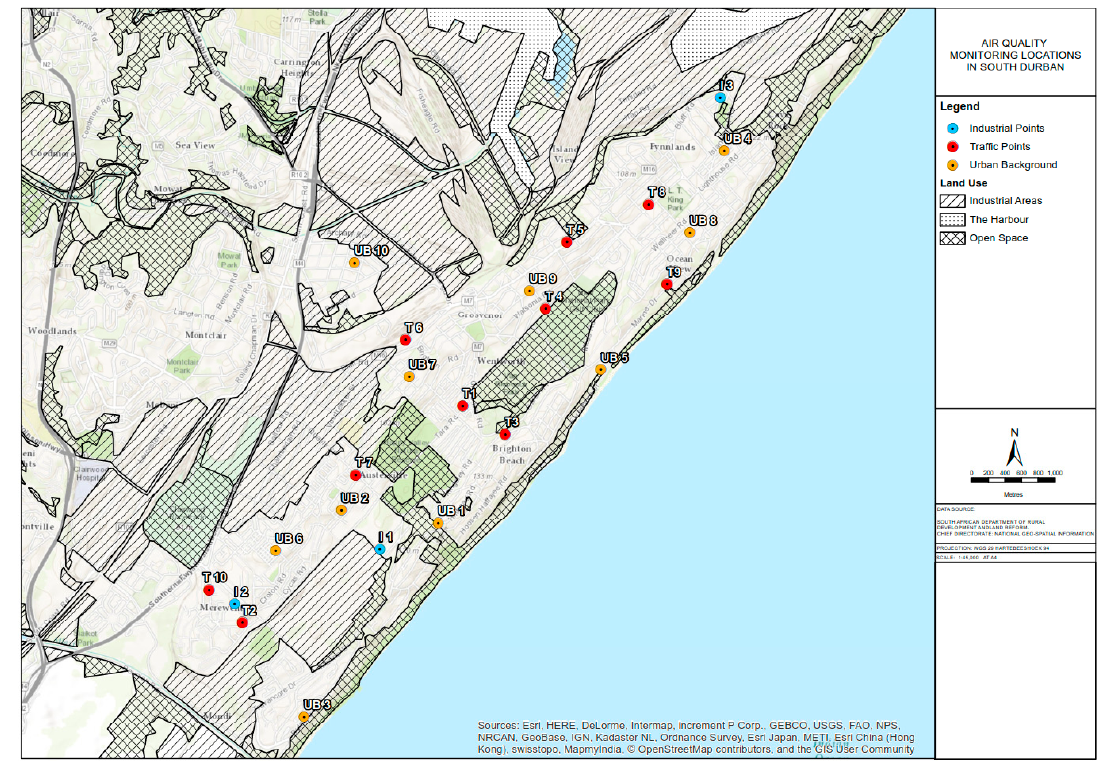
Figure 3. Location of air quality monitoring samplers in south Durban.